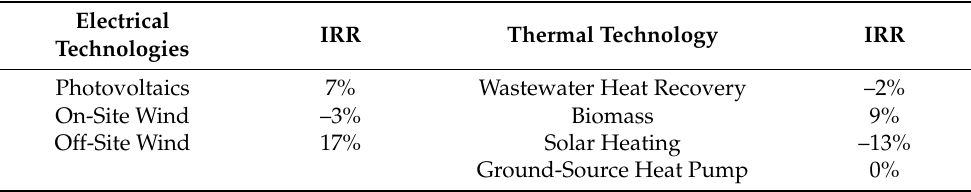
Table A1. Preliminary NWC Renewable Technology Feasibility Study Results indicating that PV, biomass, and heat pump are the preferred on-site renewable resources to achieve a net-zero